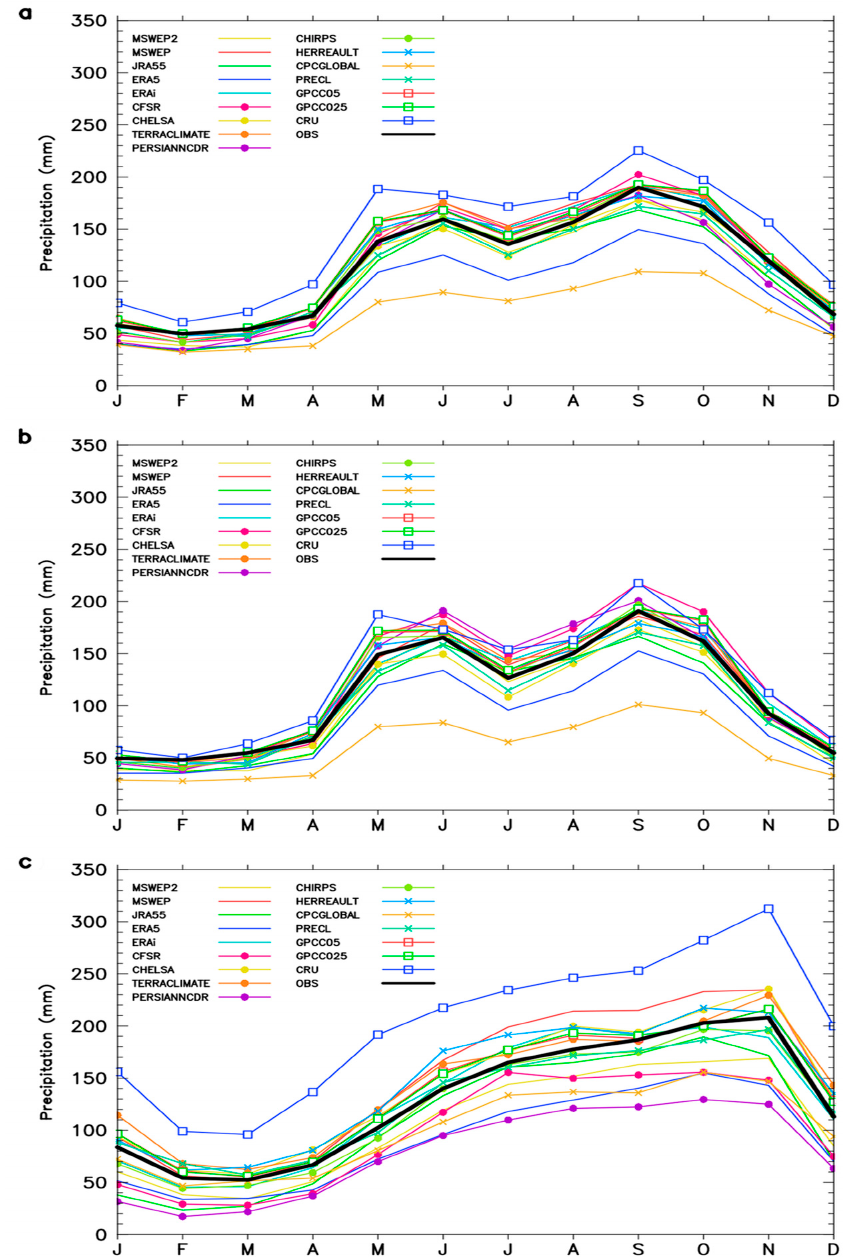
Figure 2. Annual cycle of observations and GPP, averaged over the region ( a ), western subregion ( b ) and eastern subregion ( c ) defined in Figure 1.